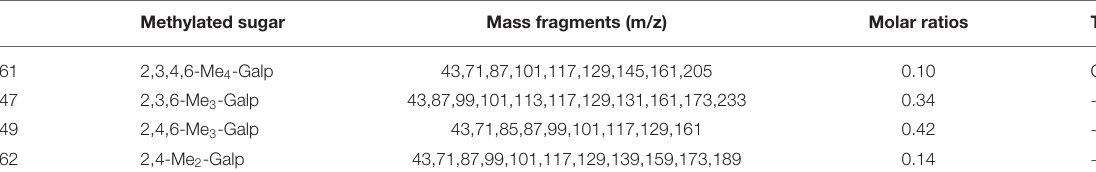
TABLE 1 | Analysis of PGP methylation.